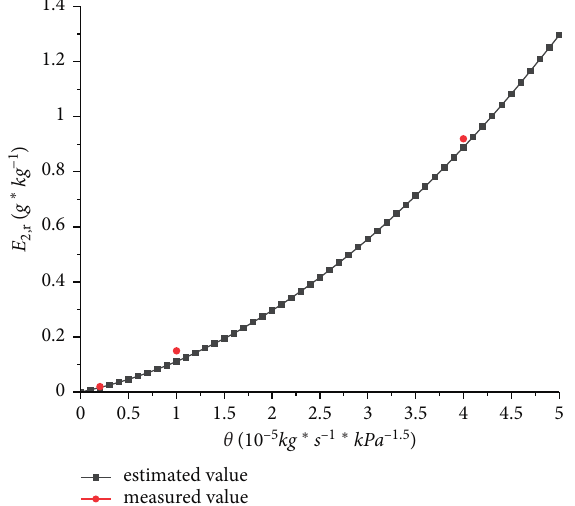
curve with θ , red dot 3 ,r